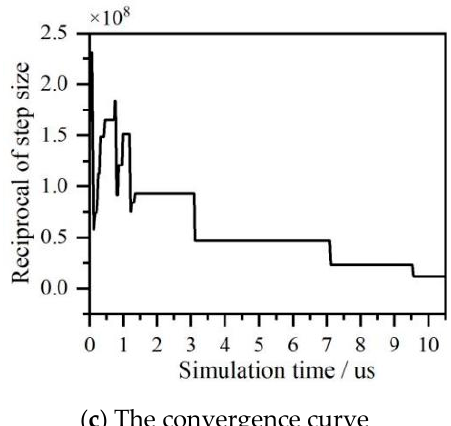
Figure 5. ( a ) Ultrasonic field generated by a laser. ( b ) Scattering waves at the cracks. ( c ) The convergence curve.